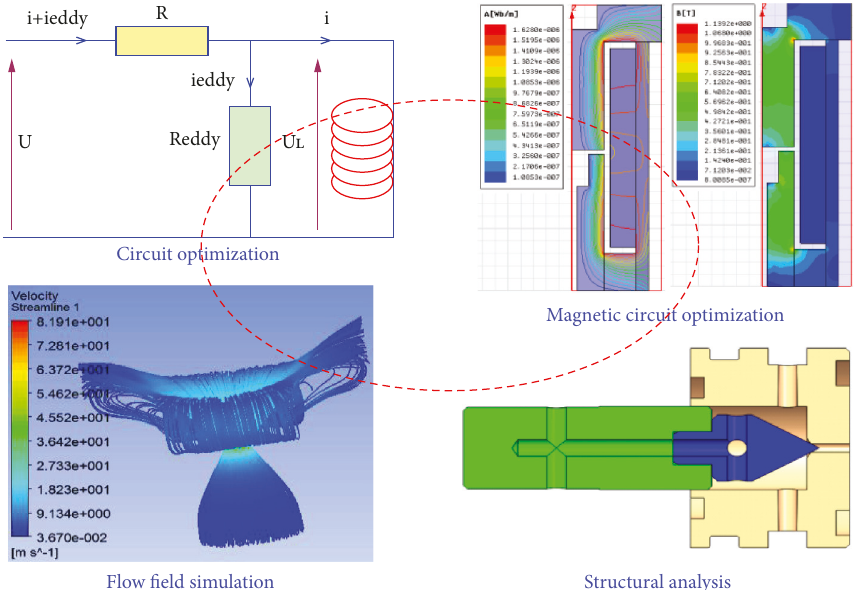
Figure 3: Electromagnetic-mechanical-hydraulic coupled system of the digital valve.